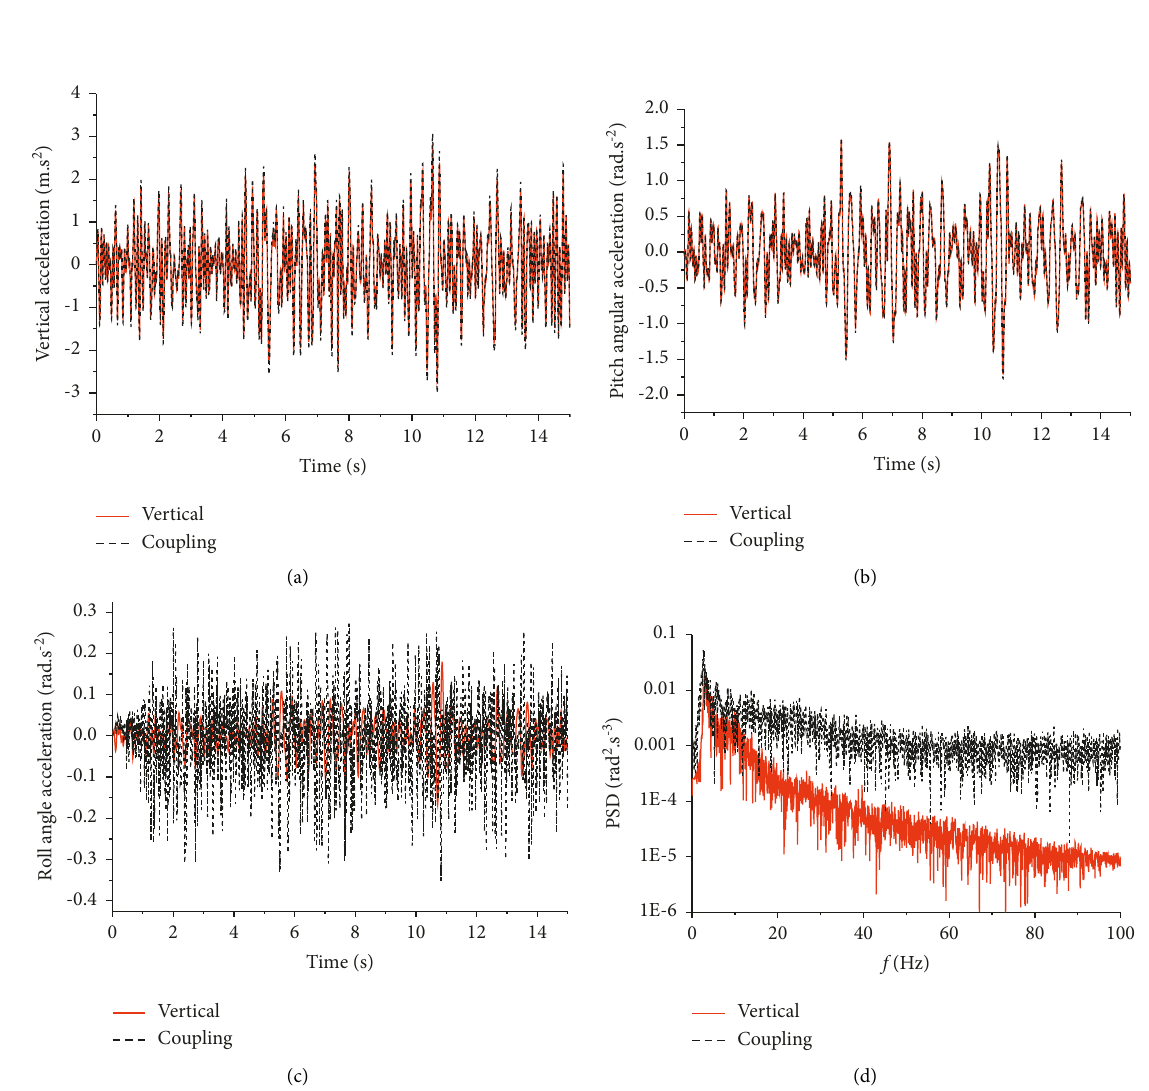
Figure 5: Ride comfort response (angular step condition, B-level random road). (a) Vertical acceleration of vehicle. (b) Car body pitching angular acceleration. (c) Roll angle acceleration time domain. (d) Roll angle acceleration frequency